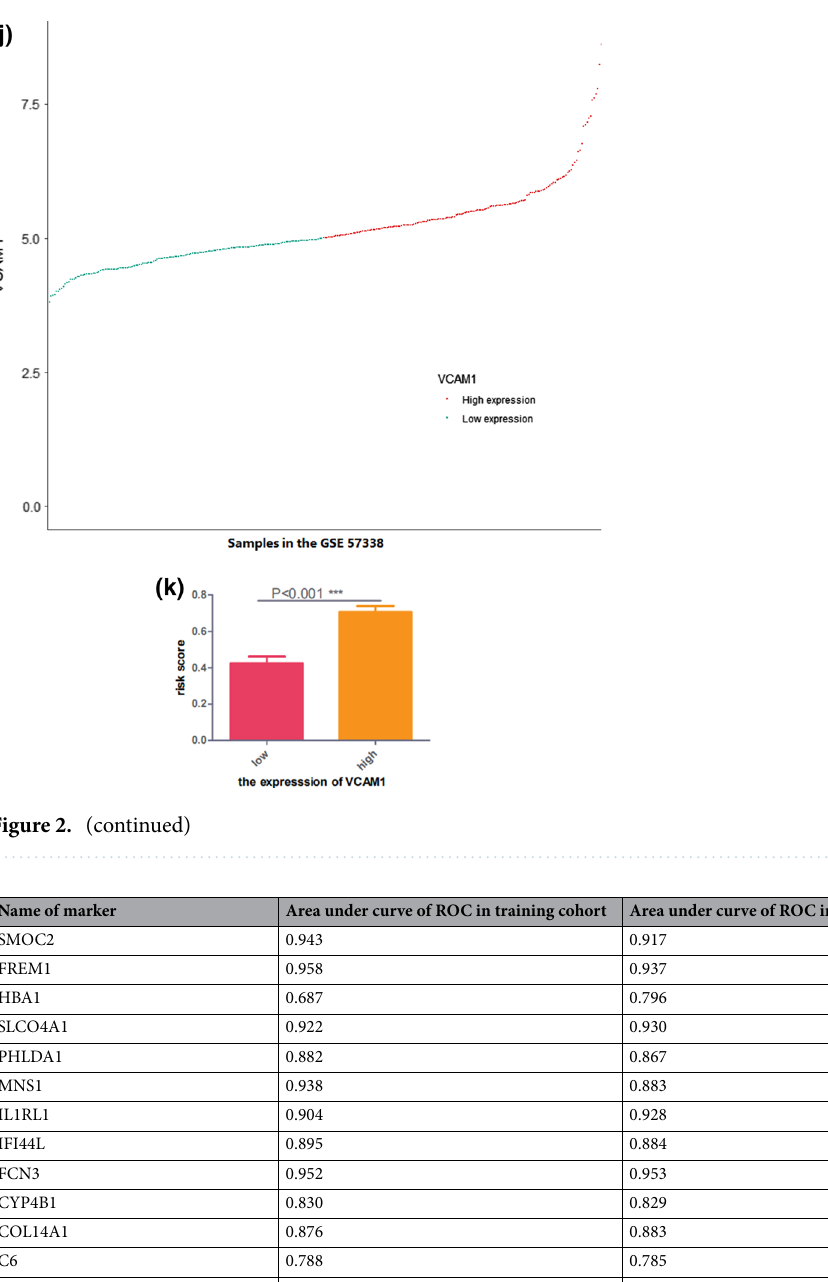
Table 1. The effectiveness indicated by the area under curve of ROC operator curve of bio-markers involved in the risk prediction model.